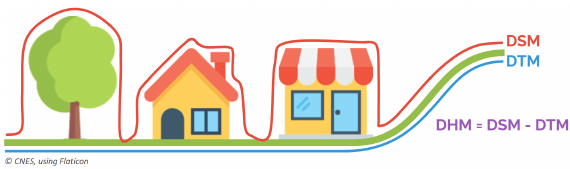
Figure 2. Difference between DSM, DTM and